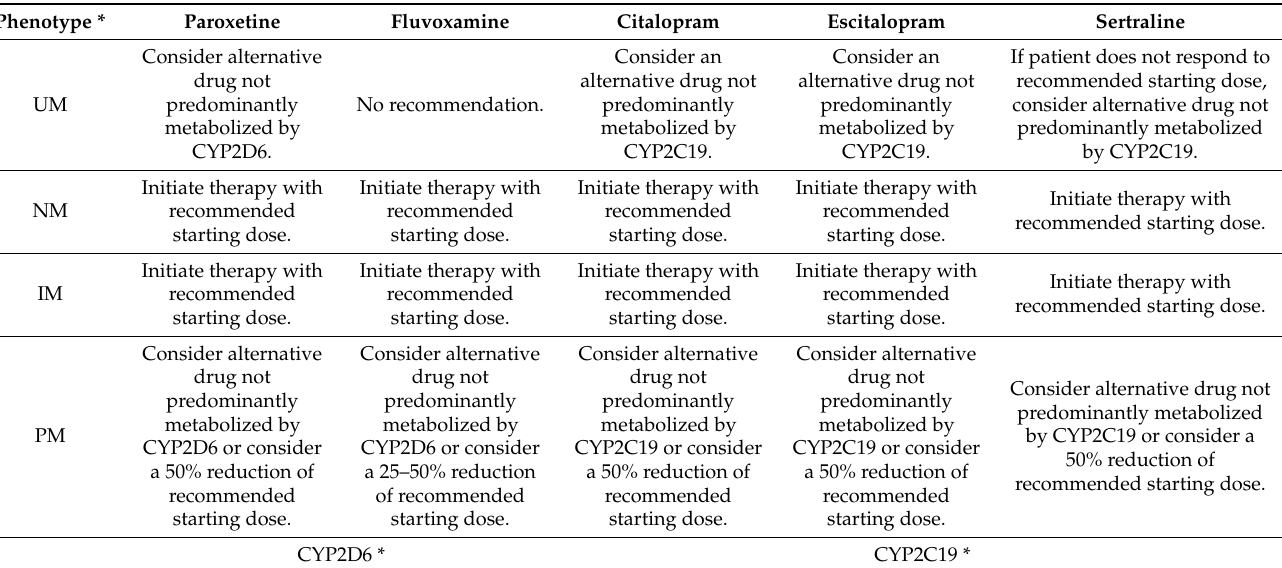
Table 1. Dosing recommendations for paroxetine, fluvoxamine, citalopram, escitalopram and